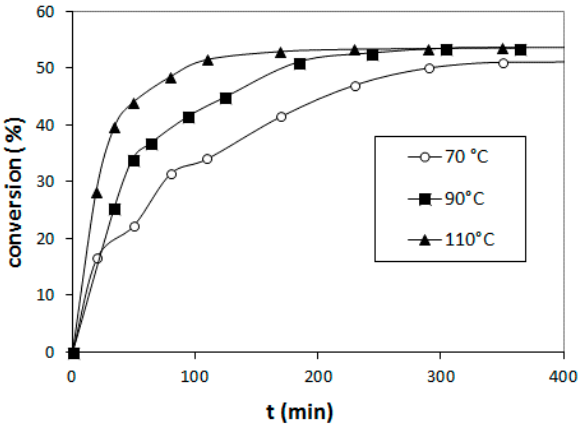
Figure 5. Conversion profiles versus time for the 1:1 esterification of lauric acid with methanol in the presence of Amberlyst-15 at different temperatures. Energies 2018 , 11 , x FOR PEER REVIEW 8 of 12